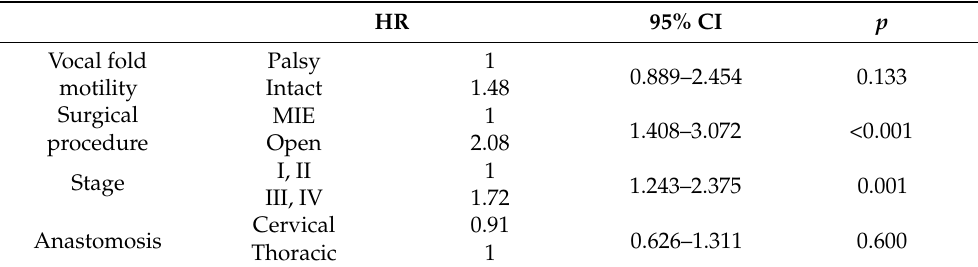
Figure 2. The overall survival is better in groups that received neck anastomosis ( A ), had stage I or II disease ( B ) and underwent minimally invasive esophagectomy ( C ). Table 2. Multivariate analysis of the factors influencing overall survival after esophagectomy.